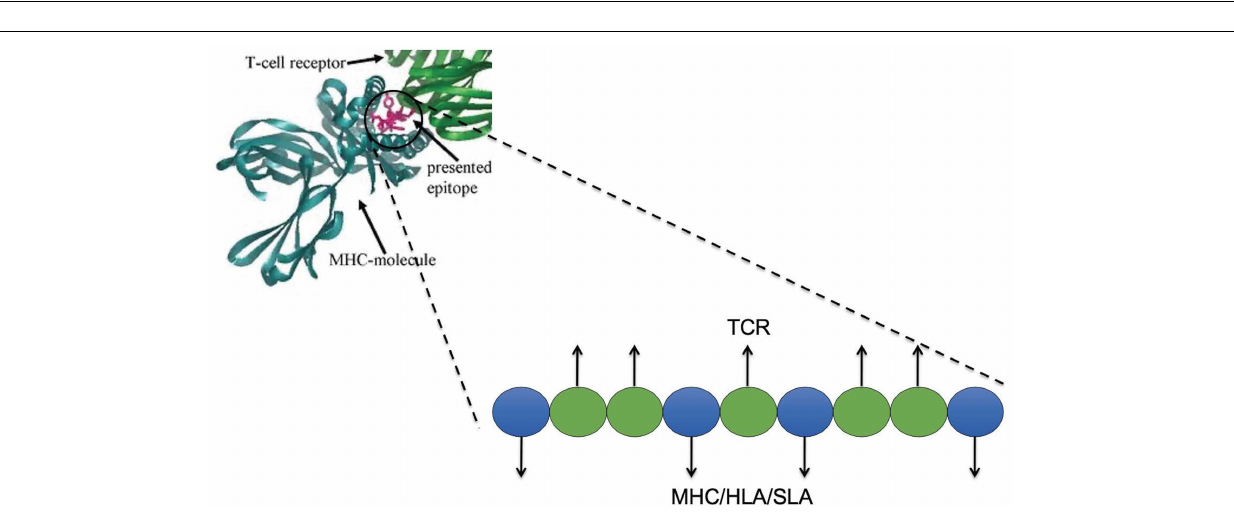
FIGURE 3 | PigMatrix class II analysis. The cluster report of a swine influenza hemagglutinin sequence shows a 9-mer frame that contains three top 1% hits (strong binding likelihood) and four top 5% hits for SLA class II alleles. This feature is called an EpiBar and is characteristic of highly immunogenic epitopes.